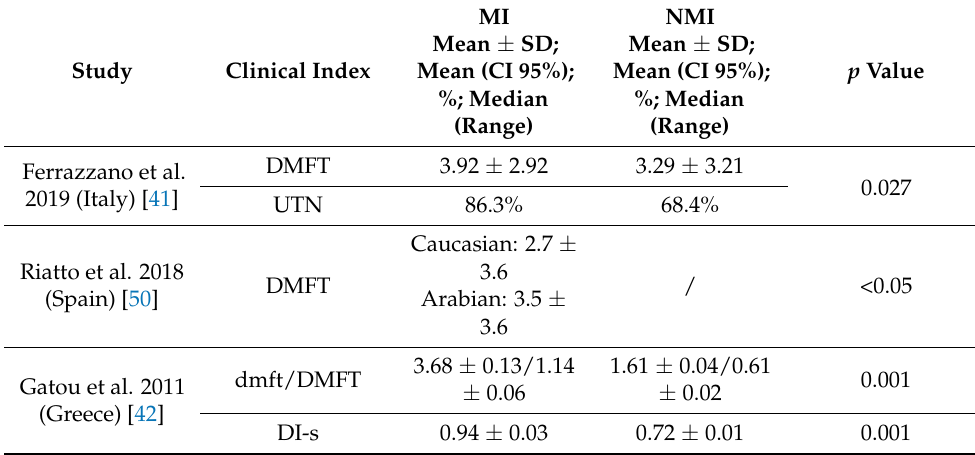
Table 14. Dental caries and periodontal status in MI and NMI living Spain, Italy and